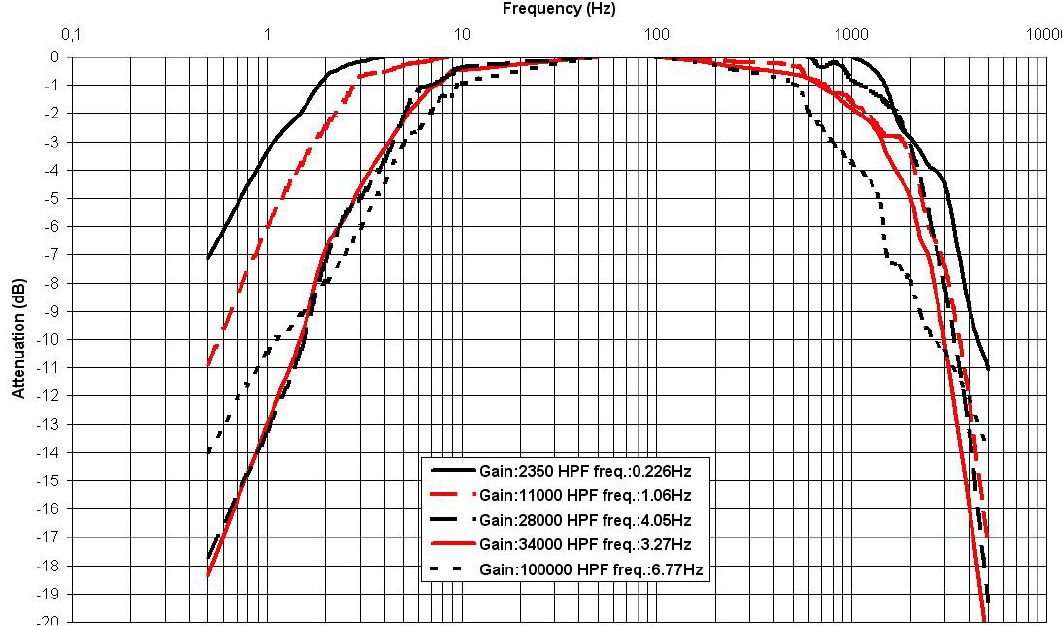
Figure 7. Normalised frequency response. Five selected gains G frequencies are displayed. LPF behaviour is achieved with a MAX7401 at the